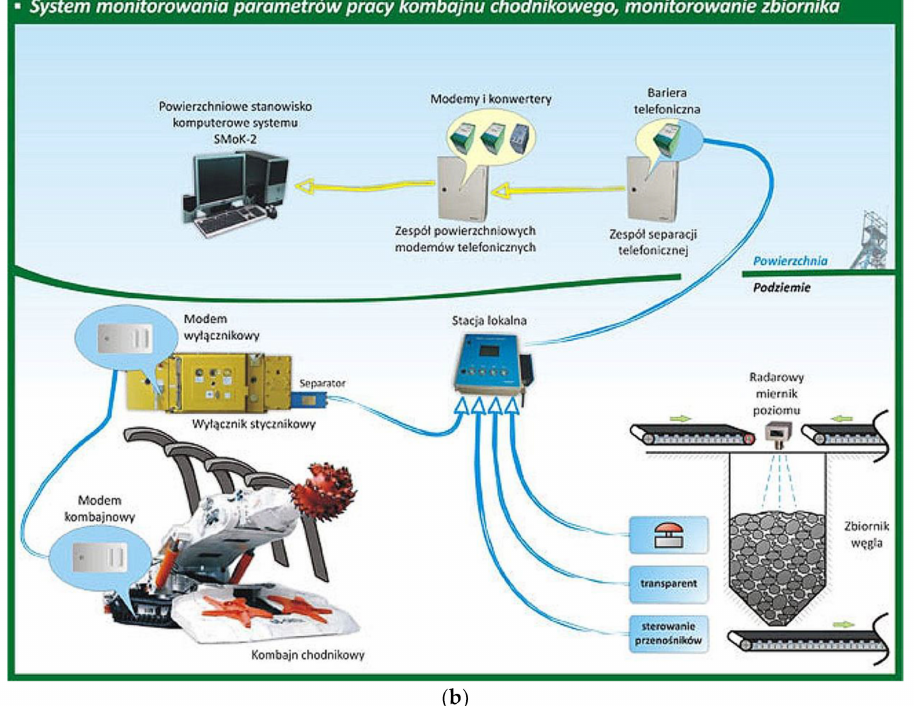
Figure 9. Data Acquisition Module—recording of measured roadheader’s operating parameters: ( a ) on a laboratory test stand, ( b ) under operating conditions using a monitoring system (the SMOK-2 system by Somar S.A. is shown here as an example)